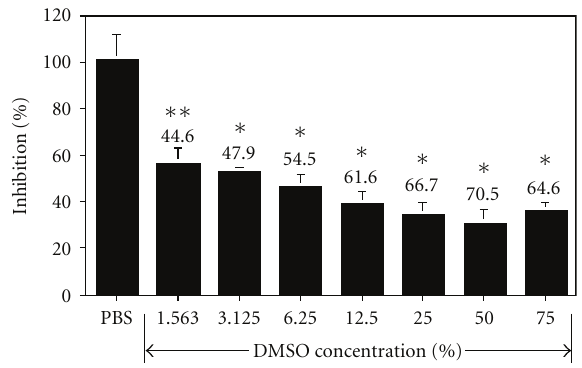
Figure 5: DMSO inhibits e ff ector T cell growth in vitro. OT-I splenocytes were prepared and incubated with indicated concentrations of DMSO (ranging 1.563%–75%) for 24 hours. MTT assay was then used to assess cell viability. Percent of cell growth inhibition was calculated and presented as mean ± standard deviation of 5 duplicate wells referring to the PBS-treated wells (100% growth). ∗ = P < . 001 and ∗∗ = P < . 05 (compared to the PBS-treated cells). The results are representative of two separate